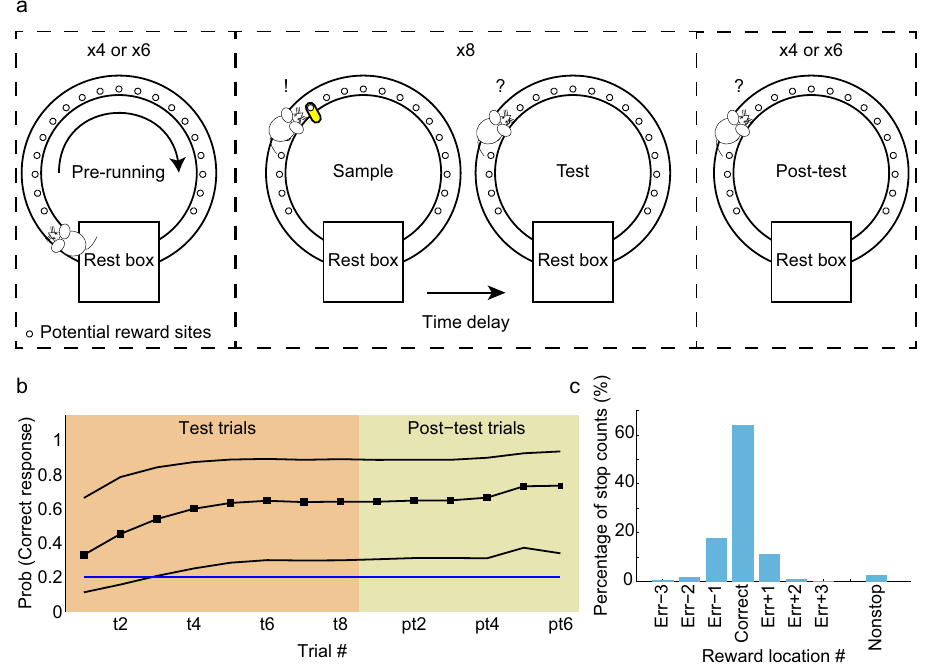
Fig. 1 Behavioral task and performance. a Schematic of delayed match-to-sample spatial memory task. Each session consisted of pre-running trials, sample-test trials, and post-test trials. In pre-running trials, rats ran 4 or 6 laps unidirectionally on a circular track without receiving any reward. One of the potential reward sites was pseudo-randomly chosen for each session. In each session, rats performed 8 paired sample-test trials. The correct reward location was marked with a visual cue (yellow marker) during the sample phase. The marker was removed in the test phase, which began 30 sec after the sample phase. After a 5-minute delay, a post-test phase of the task began, which consisted of test trials only (i.e., no cue marked the correct reward location during this phase). Rats received a reward if they stopped at the correct goal location during the sample, test, and post-test trials. The goal/reward location remained constant within a session. b Behavioral performance across test (orange, t1-t8) and post-test (beige, pt1-pt6) trials is shown. Black solid lines represent the mean probability of making a correct choice across recording sessions, bounded by 95% con fi dence intervals. The blue horizontal line indicates chance performance. c Proportion of trials in which rats stopped at different locations in test and post-test trials pooled across all recording sessions. Err-n and Err + n ( n = 1, 2, 3) indicate stop locations that were n locations before or after the correct reward location. Nonstop indicates that rats did not stop at any location in that